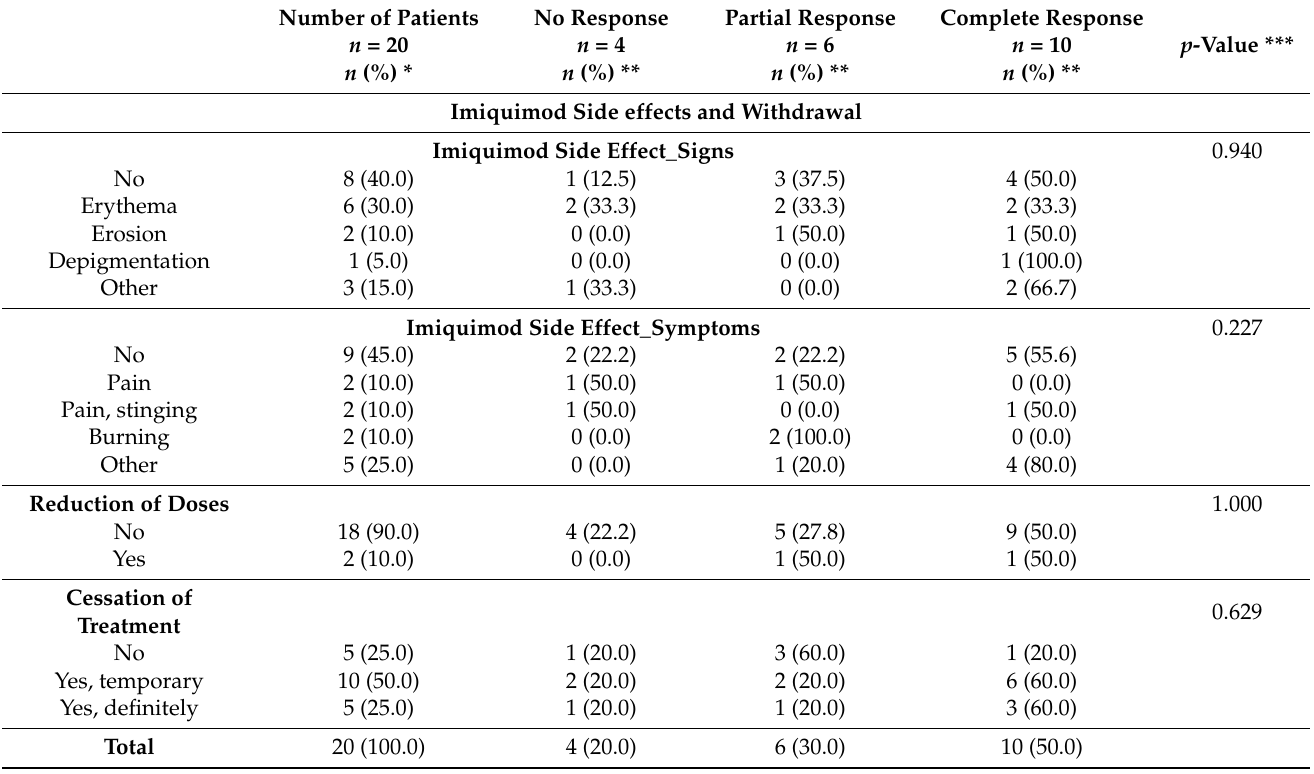
Table 4. Imiquimod side effects and withdrawal. Patients treated with imiquimod for vulvar high- grade squamous intraepithelial lesion (vulvar HSIL).